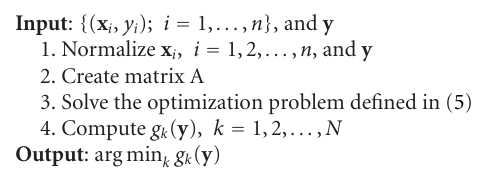
Algorithm 1: Classification by sparse